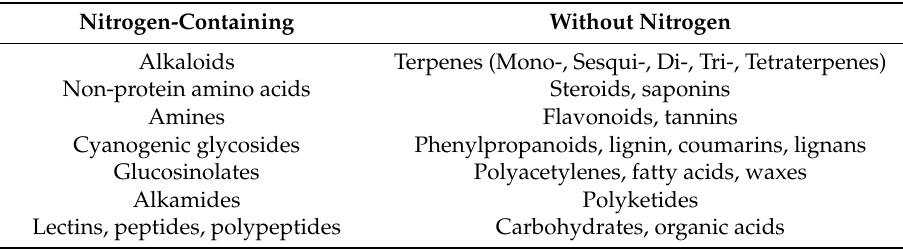
Table 1. Secondary metabolite groupings. Table 1 . Secondary metabolite groupings.